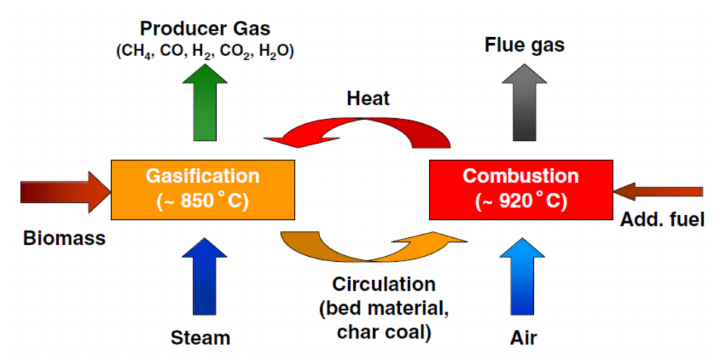
Figure 1. Principle of the DFB gasifier [13,33,34].